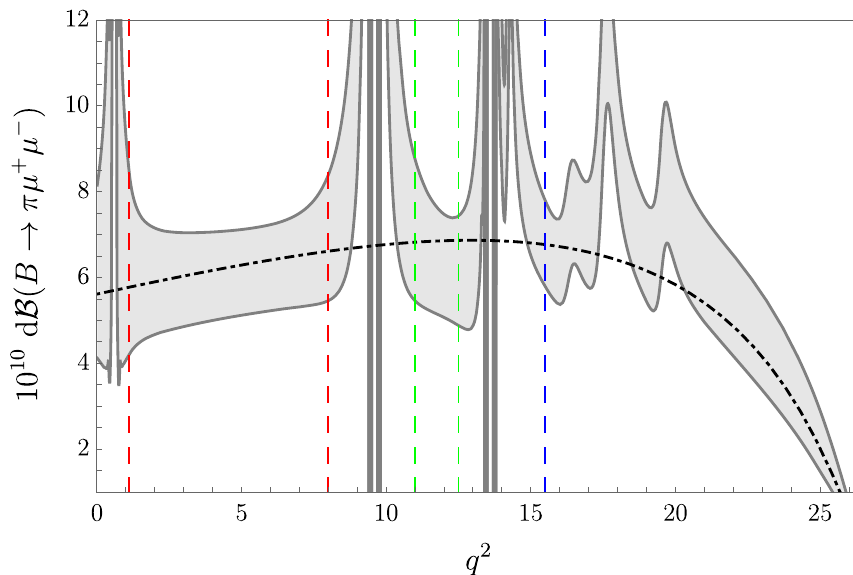
Fig. 1 Dilepton spectrum in B + → π + μ + μ − within the SM. The dotted-dashed line indicate the perturbative contribution (ignoring its parametric uncertainty). The gray error band represents the 68% interval after sampling over magnitudes and phases of the vector resonance contributions. The vertical dashed lines denote the three short-distance dominated regions where we provide precise estimates of R π (see text for